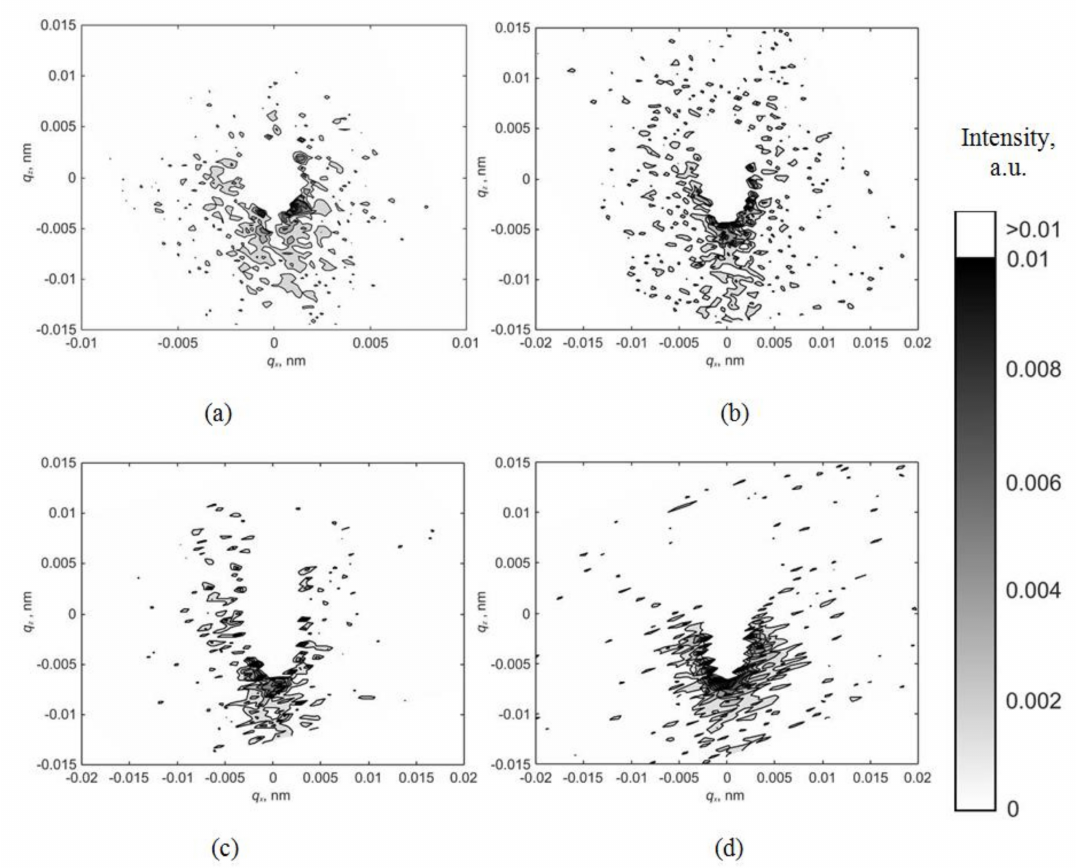
Figure 2. Maps of the asymmetric part of diffuse scattering for reflections ( a ) − (110); ( b ) − (220); ( c ) − (330); ( d ) − (440) at a voltage of 0